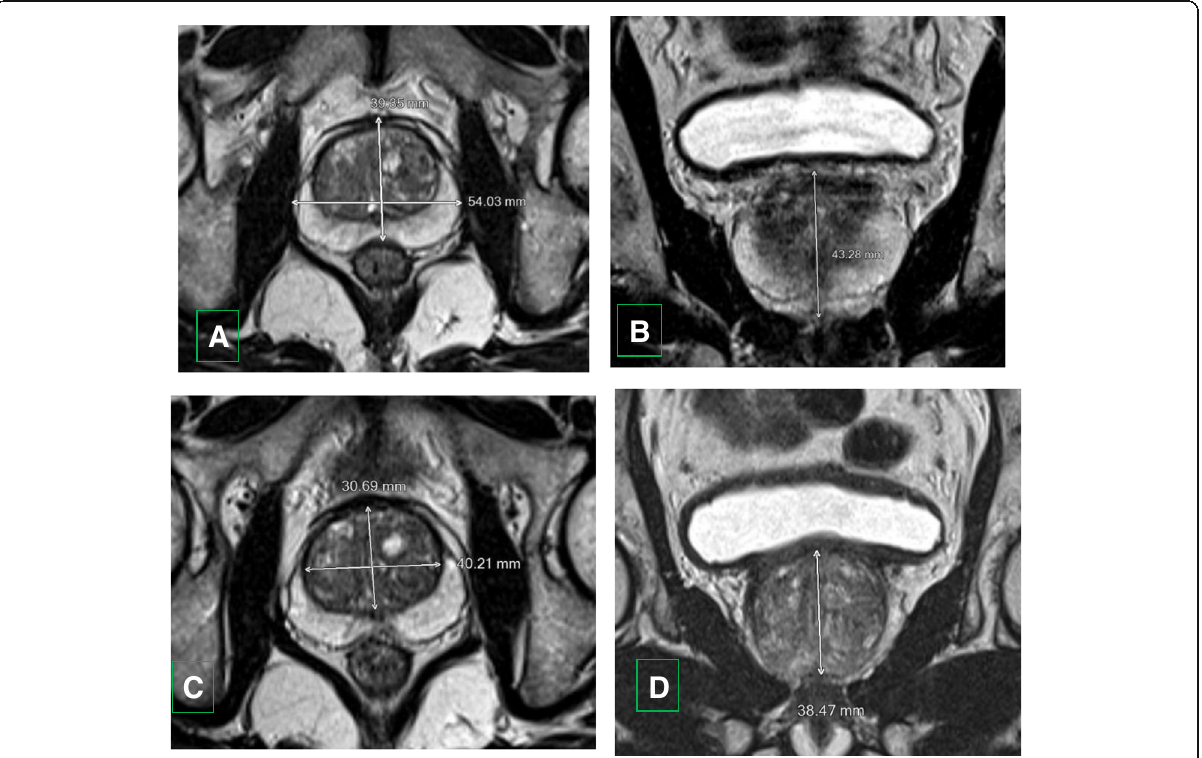
Fig. 1 Ellipsoid prostate volume measurement on axial and coronalT2-weighted MR images. a , b Total prostate volume (TPV) measurement. a Axial T2 WI showing anteroposterior and right-to-left dimensions. b Coronal T2 WI showing superoinferior dimension of the entire prostate. c , d Transition zone (TZ) volume (TZV) measurement. c Axial T2 WI showing anteroposterior and right-to-left dimensions. d Coronal T2 WI showing superoinferior dimension of the transition zone (TZ) of the